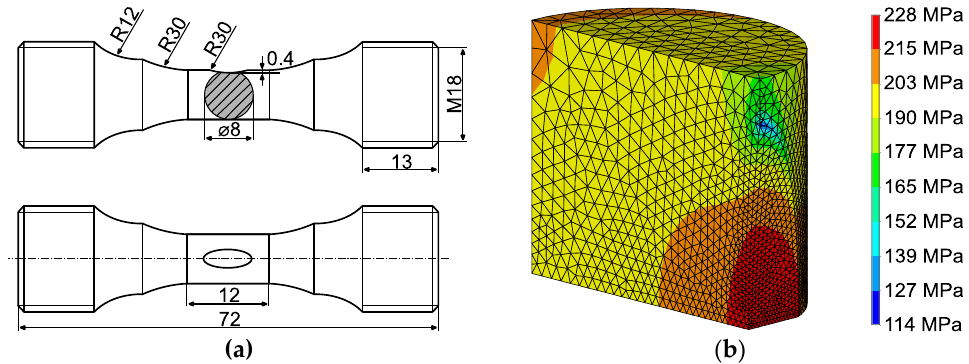
Figure 2. Overview of the specimen geometry: ( a ) The specimen with a shallow notch in the middle of the gauge length. ( b ) The gauge length segment of the finite element model used for the estimation of theoretical stress concentration factor of the notch (Y axis is the loading direction). Stress distribution under monotonic loading.